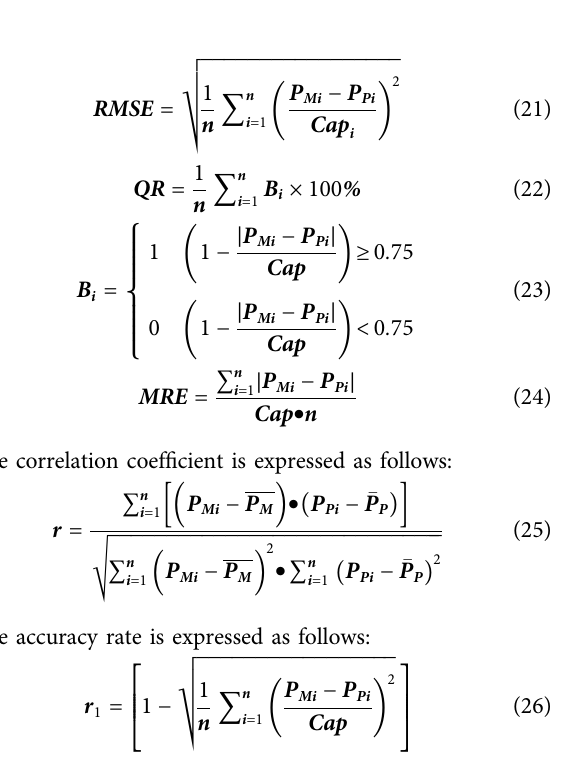
FIGURE 3 | Establishment of the improved generalized error mixture distribution